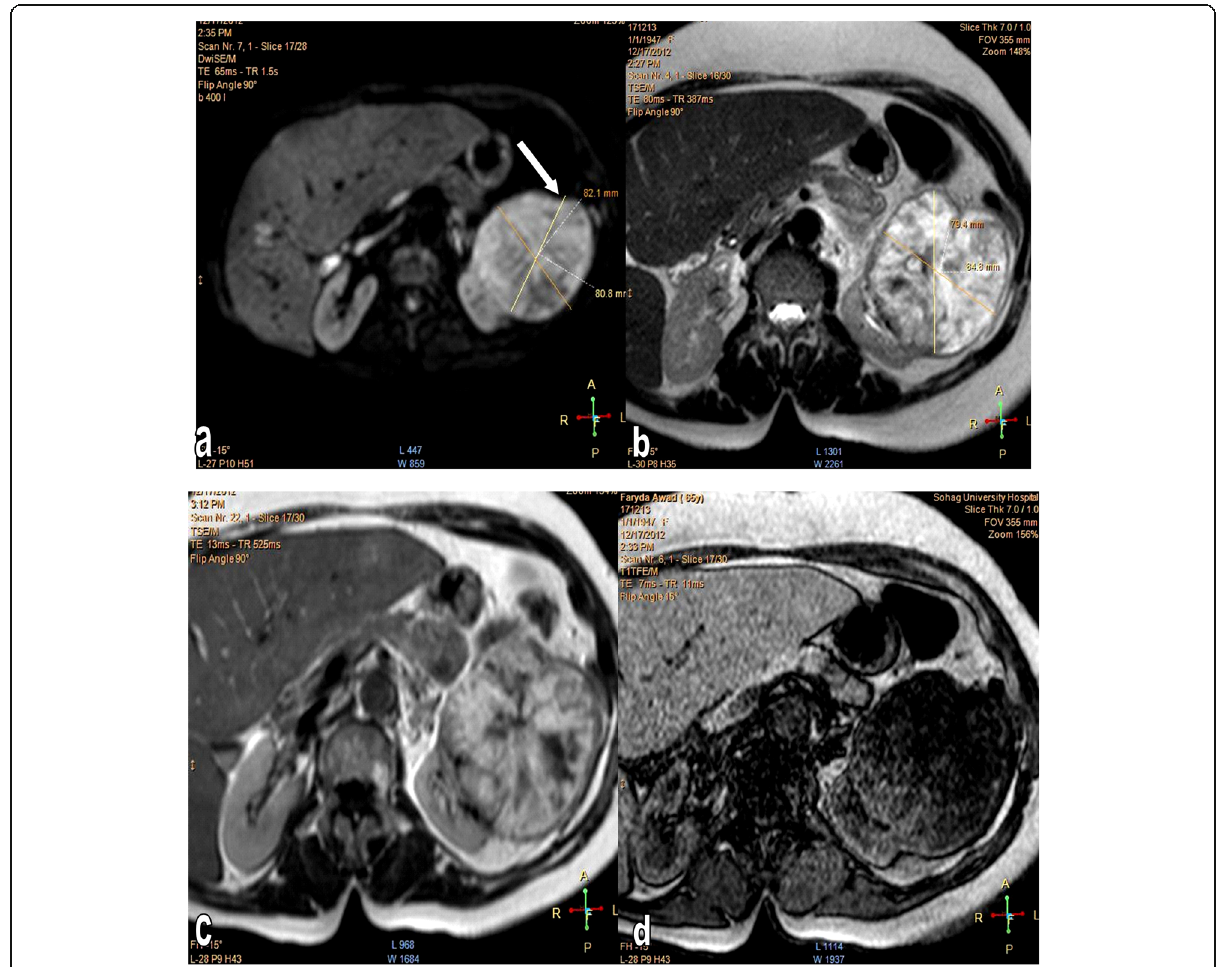
Fig. 1 65-year-old man with clear-cell renal cell carcinoma in left kidney. a Axial T1-weighted image shows the infiltrative tumor (arrow) as slightly hyperintense. b On T2-weighted MR image, the tumor (arrow) shows heterogeneous hyperintensity, as compared to the normal cortex. c Contrast-enhanced axial T1-weighted images show heterogeneous enhancement in the tumor (arrow) at corticomedullary phase and restricted diffusion on DWI; the ADC value was 1.6 × 10 − 3 mm 2 /s ( d